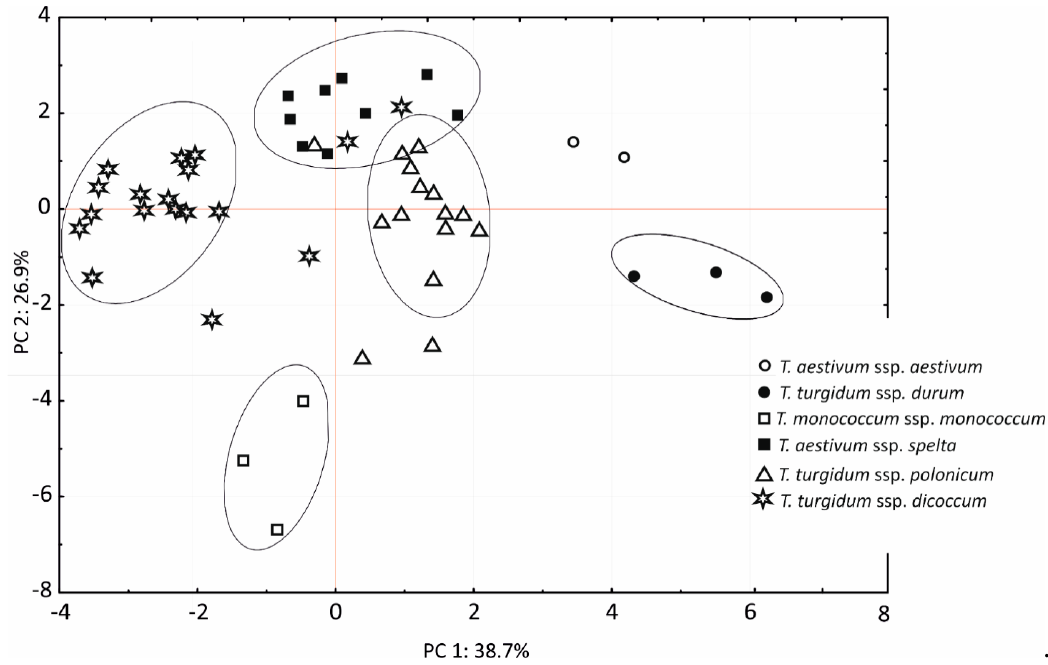
Figure 5. The results of principal component analysis (PCA) for shape and color descriptors of wheat species. Gaussian distribution confidence ellipses were drawn for the probability of 80%. Table 6. Correlation coefficients ( r) between a variable and a principal component (PC) and the contribution of each variable to the PCs.